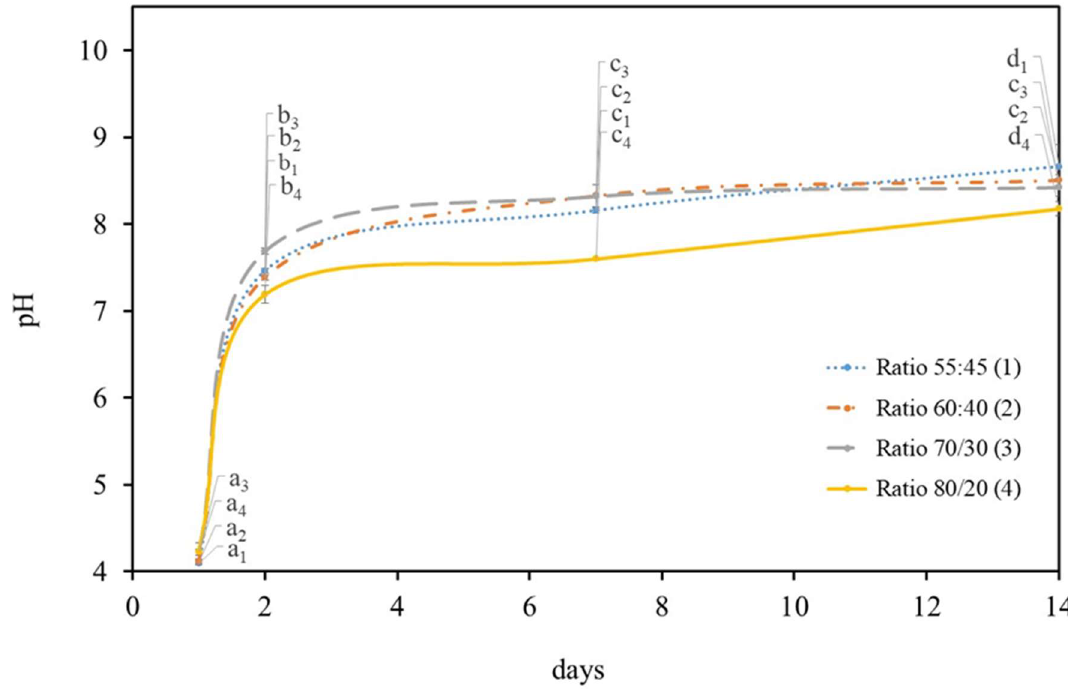
Figure 2. pH variation in different HS:BG-11 ratios media, for 14 days of K. saccharivorans and C. debaryana (0.75% ( w/v )) at 30 °C. Values in the same curve do not share a common letter (index according to each HS:BG-11 ratio) are statistically different ( p < 0.05).